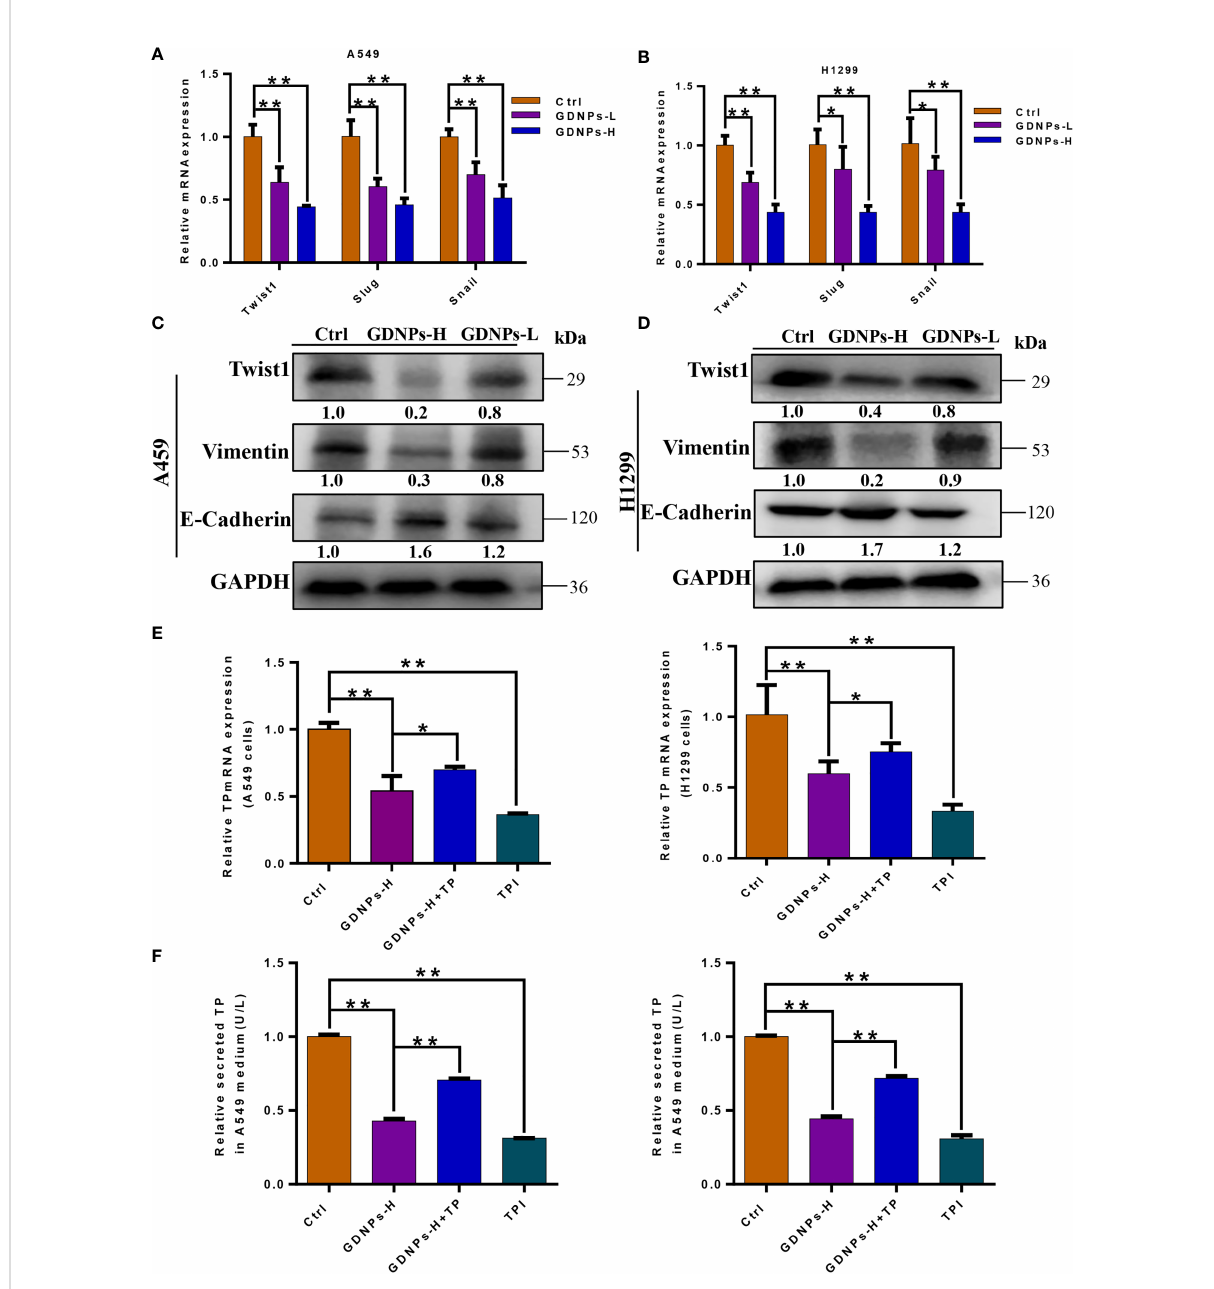
FIGURE 5 GDNPs treatment reduced levels of EMT-related makers and TP expression. (A, B) Expression of genes encoding epithelial and mesenchymal marker proteins in A549 and H1299 cells as measured via qRT-PCR after treatment of cells with GDNPs for 24 h. (C, D) Western blot results showing A549 and H1299 cells treated with GDNPs exhibited relatively decreased levels of vimentin and Twist1 and increased E-cadherin level as compared to untreated cells. (E) Results of qRT-PCR analysis showing expression levels of TP mRNA in A549 and H1299 cells. (F) Enzyme- linked immunosorbent assay results showing TP levels in medium of cultured cells. Data are presented as the mean ± SD of three experiments (*P < 0.05 and **P <